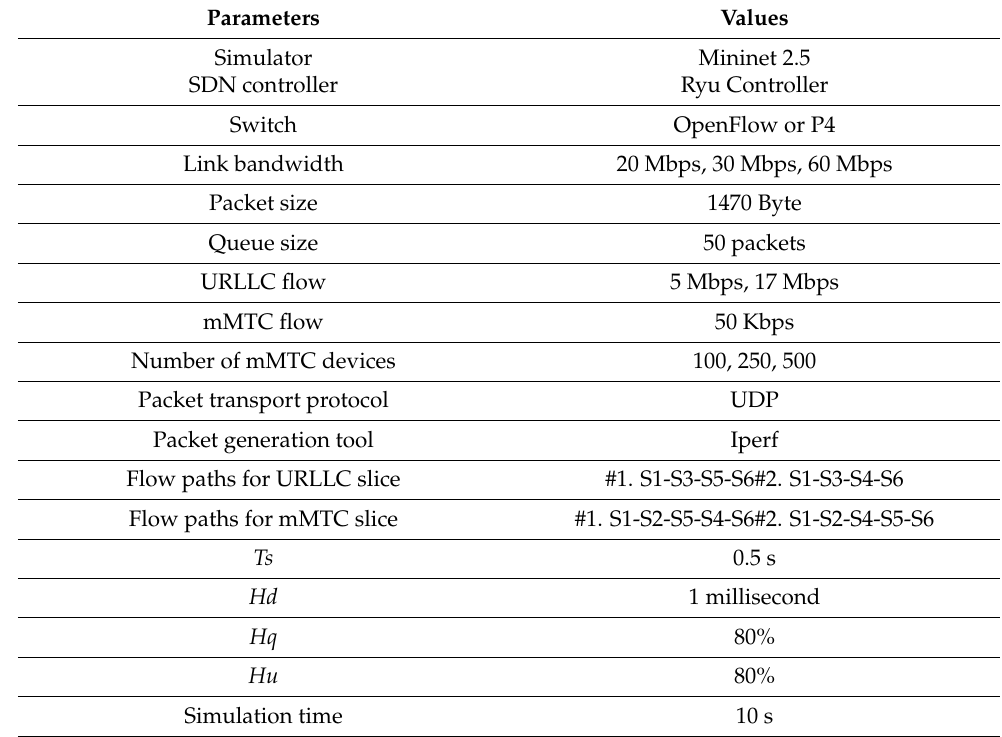
Figure 10. SDN topology used in the simulation. Table 4. Simulation parameter settings.